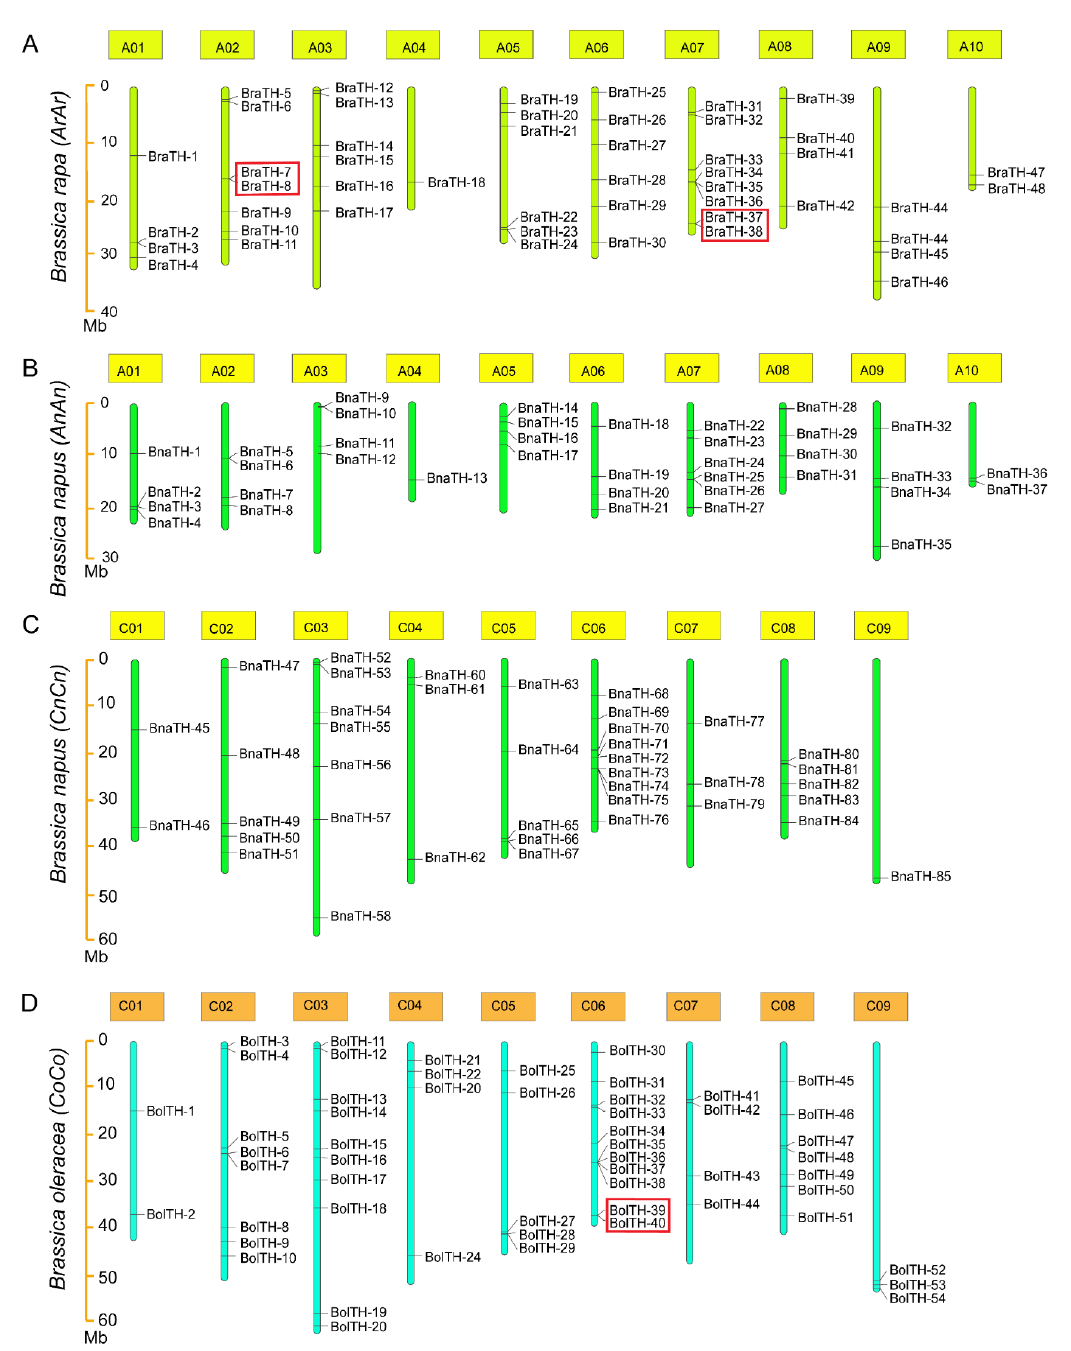
Figure 3. Chromosomal distribution of BraTH genes, BolTH genes, and BnaTH genes. The colored bars represent chromosomes, and the chromosome numbers are shown at the top of the bars. TH genes are labeled at the right of the chromosomes. The scale on the left side indicates the chromosome length (Mb). ( A ) Chromosomal localization of BraTH genes in B. rapa . ( B ) Chromosomal localization of BnaTH genes in A subgenome of B. napus . ( C ) Chromosomal localization of BnaTH genes in C subgenome of B. napus . ( D ) Chromosomal localization of BolTH genes in B. oleracea . Genes in the red box are tandem duplication